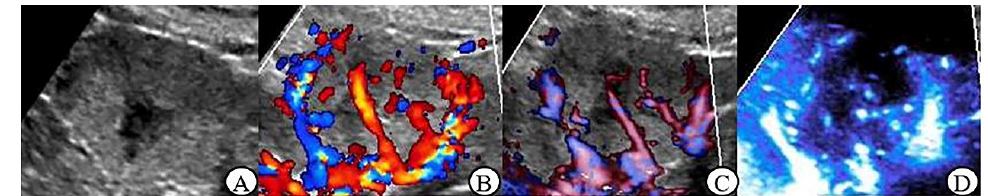
Figure 4. Clear cell carcinoma (largest diameter: 4.1 cm) ( A ): Gray scale ultrasound: the mass with clear boundary, hypoechoic, heterogeneous, and the cystic lesions was explored; ( B ): CDFI: irregular blood flow signal was observed in the lesion, Adler Grade 3, peripheral annular blood flow was recorded; ( C ): PDI: irregular blood flow signal was observed in the lesion, Adler Grade 3, there is no annulus blood flow; ( D ): MFI: irregular blood flow pattern within the lesion, Adler Grade 3, peripheral annular blood flow was not obvious.